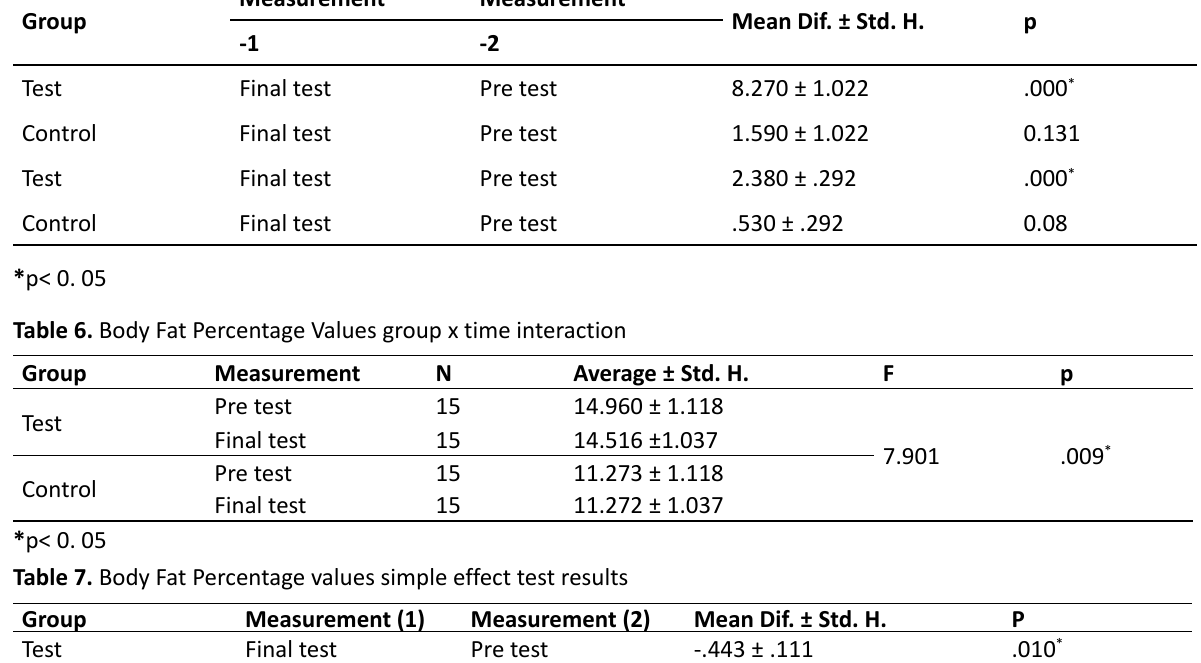
Table 5. VO Estimate Mg/kg/min and Met values simple effect test results 2Max Group